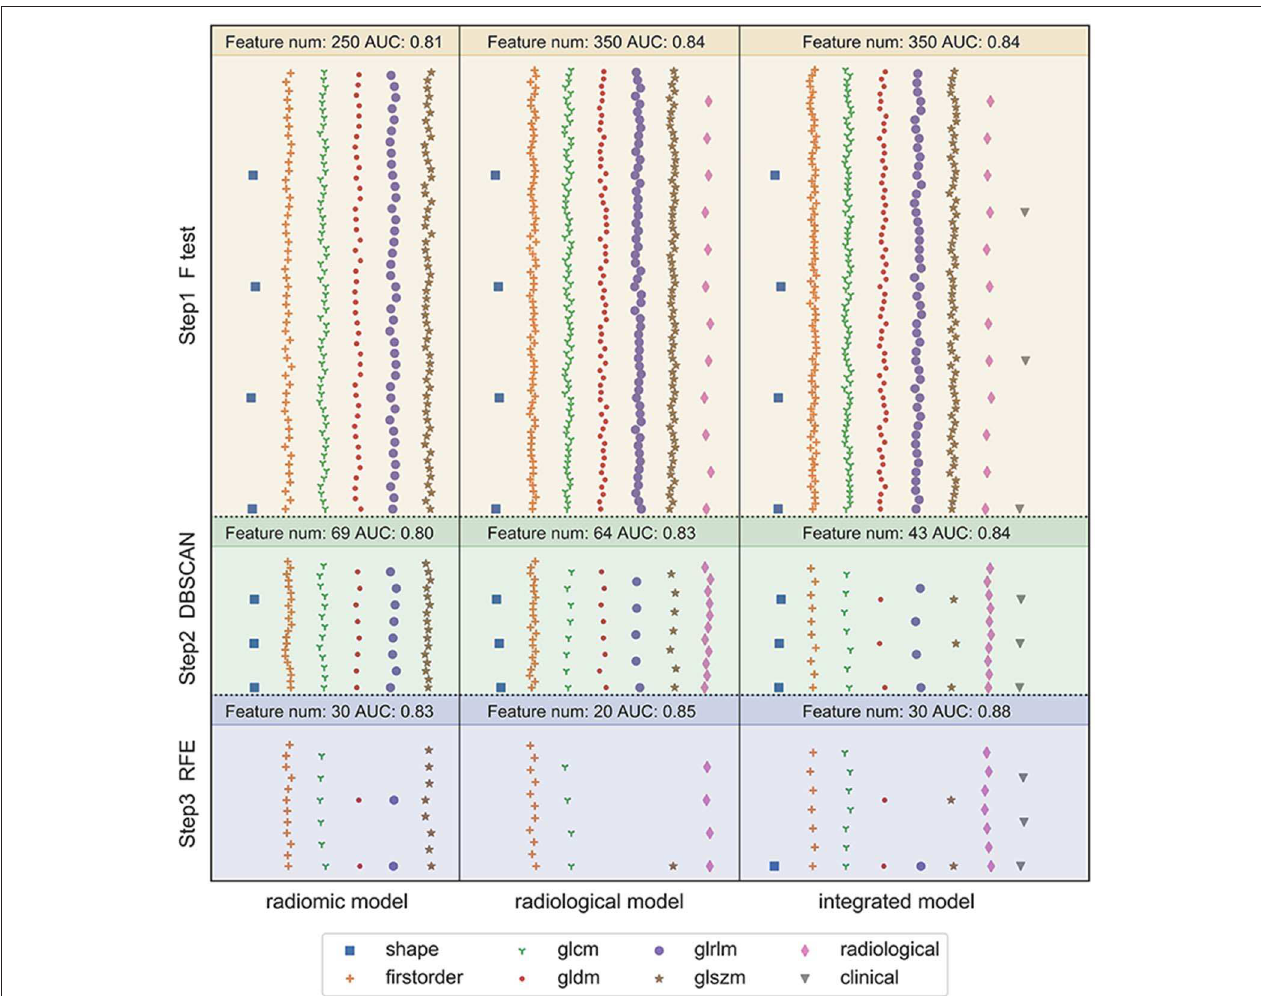
FIGURE 4 | Illustration of the feature selection procedure in the three models. Each vertical panel exhibits the selection process for each of the three predictive models. Each symbol indicates a different type of feature. The number of selected features along with the optimal AUC obtained at each selection step was shown at the top of each sub-panel. In the radiomic model, 1,218 extracted radiomic features were used to begin the selection. In the radiological model, the initial features included 12 conventional CT features and 1,218 radiomic features. In the integrated model, seven clinical characteristics were added in addition to the 12 conventional CT features and 1,218 radiomic features. The features were selected to maximize the AUC of the predictive model at the final